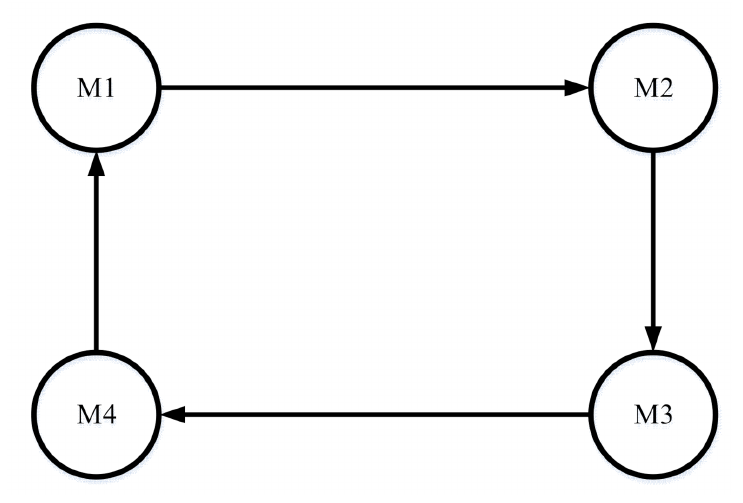
Figure 2. Communication topology among UAVs.